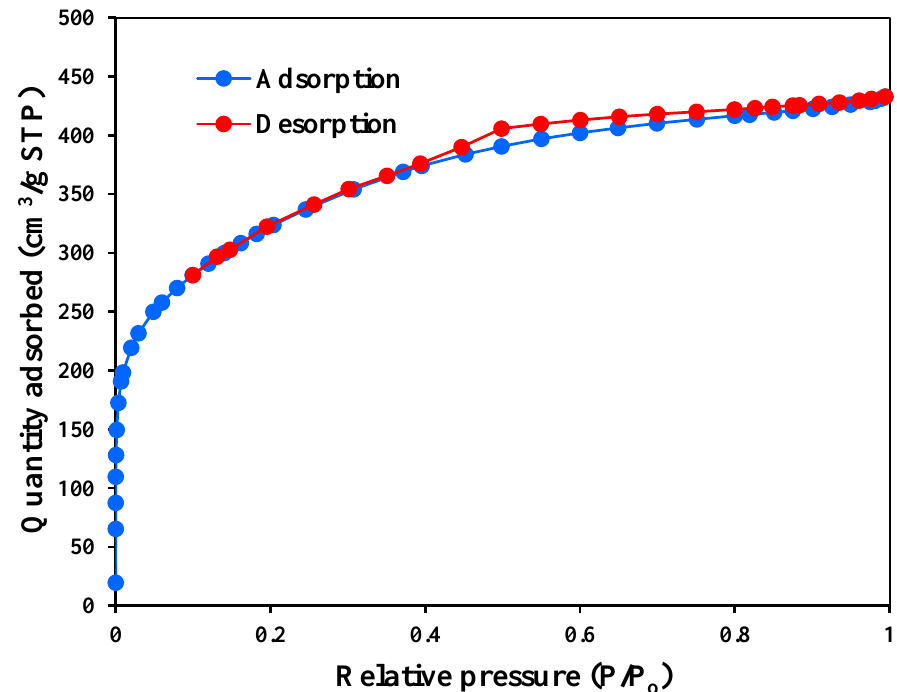
Figure 1. N 2 adsorption-desorption isotherms and pore size distribution of MSMPAC.